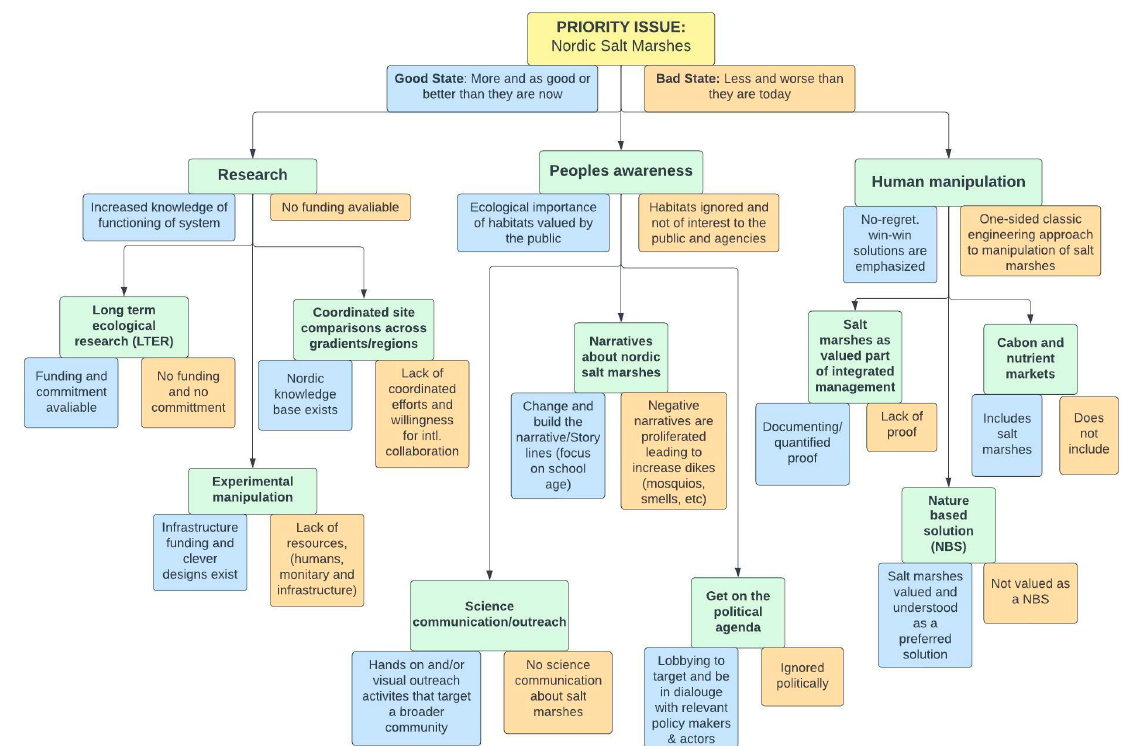
Figure 1. Priority issues mapped with online sticky notes during the workshop and later transferred to LucidChart for better readability. The green boxes represent the various ‘stem variables’ while the blue boxes are the ‘good state’ of said scenario and the orange represents the ‘bad state’ or worse case state of the stem variable, as decided upon by the workshop participants.